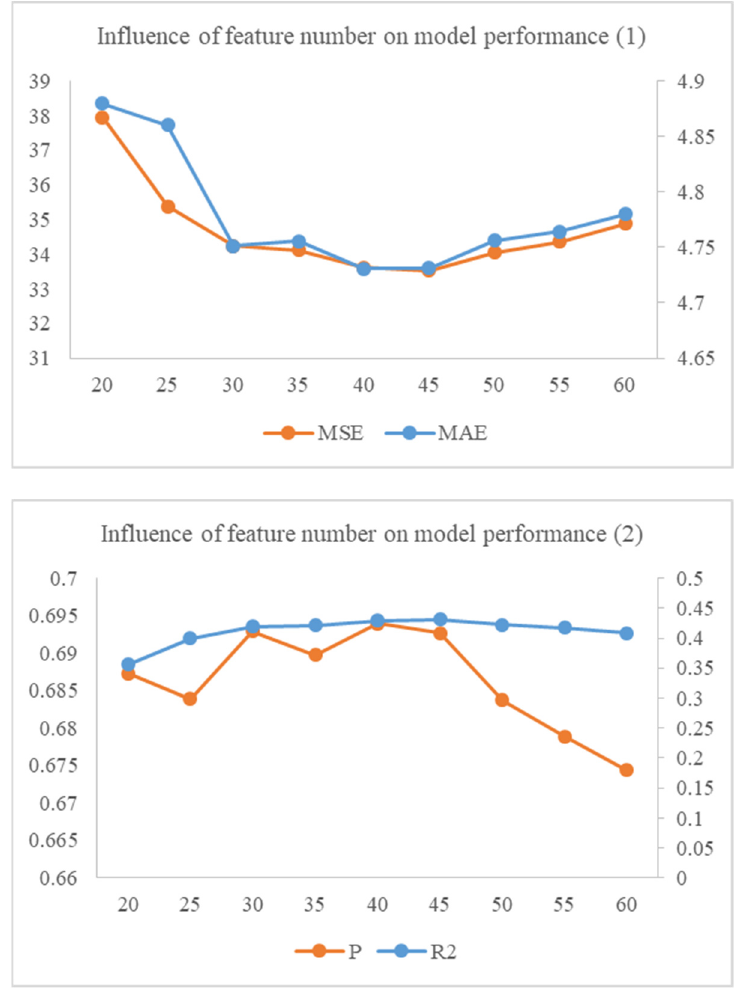
Figure 2. The trend of evaluation scores (r, MAE, MSE, R2) changing with the number of features. Smaller Mae and MSE scores represent that the predicted scores are closer to the real scores, while larger R2 and r values represent that the predicted scores are more related to the real scores.